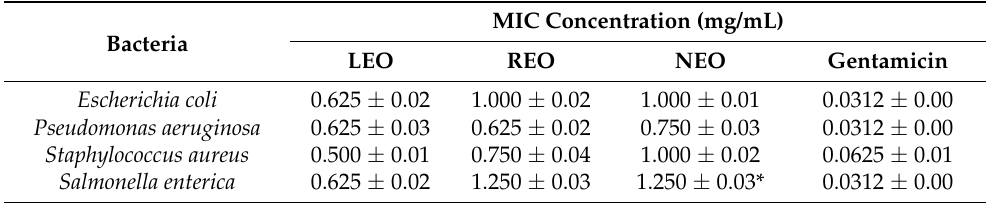
Table 6. Antibacterial activity of Curcuma spp. leaves essential oils evaluated as minimum inhibitory concentrations ( µ g/mL) of leaf essential oils of different Curcuma